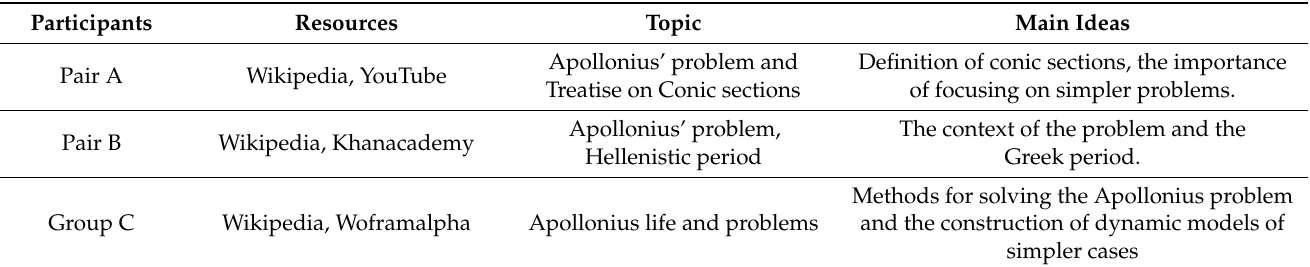
Table 1. Topics addressed by the participants in their essay on the Apollonius